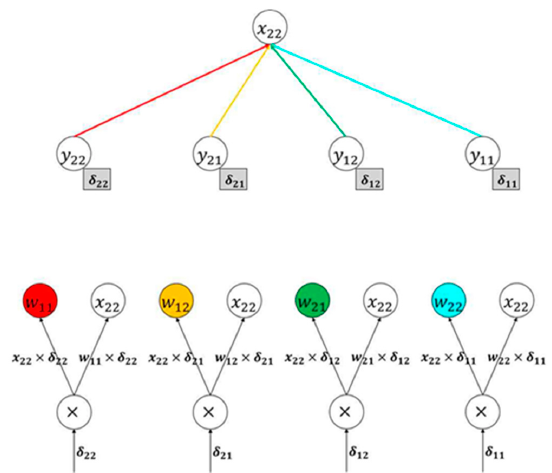
Figure 12. Karpathy calculation graph of x (cid:2870)(cid:2870) backpropagation.